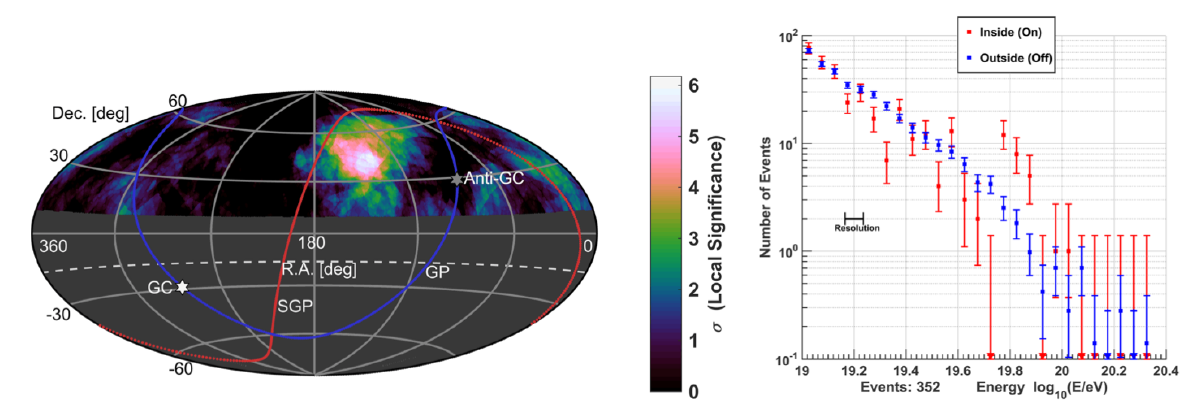
Figure 4. (Left) The significance map of the spectral anisotropy above 10 19 : 2 eV which is smoothed by 14.03% equal exposure spherical cap bins (from [7]). Solid curves indicate the galactic plane (GP) in blue and supergalactic plane (SGP) in red. The Galactic center (GC) is indicated by a white star and anti-galactic center (Anti-GC) by a gray star. (Right) The energy distribution inside the spherical cap bin (red) at the maximum significance position (R.A. = 9 h 16 m , Dec. = 45 ◦ ) in the direction of the Hotspot, compared to the expected distribution (blue).